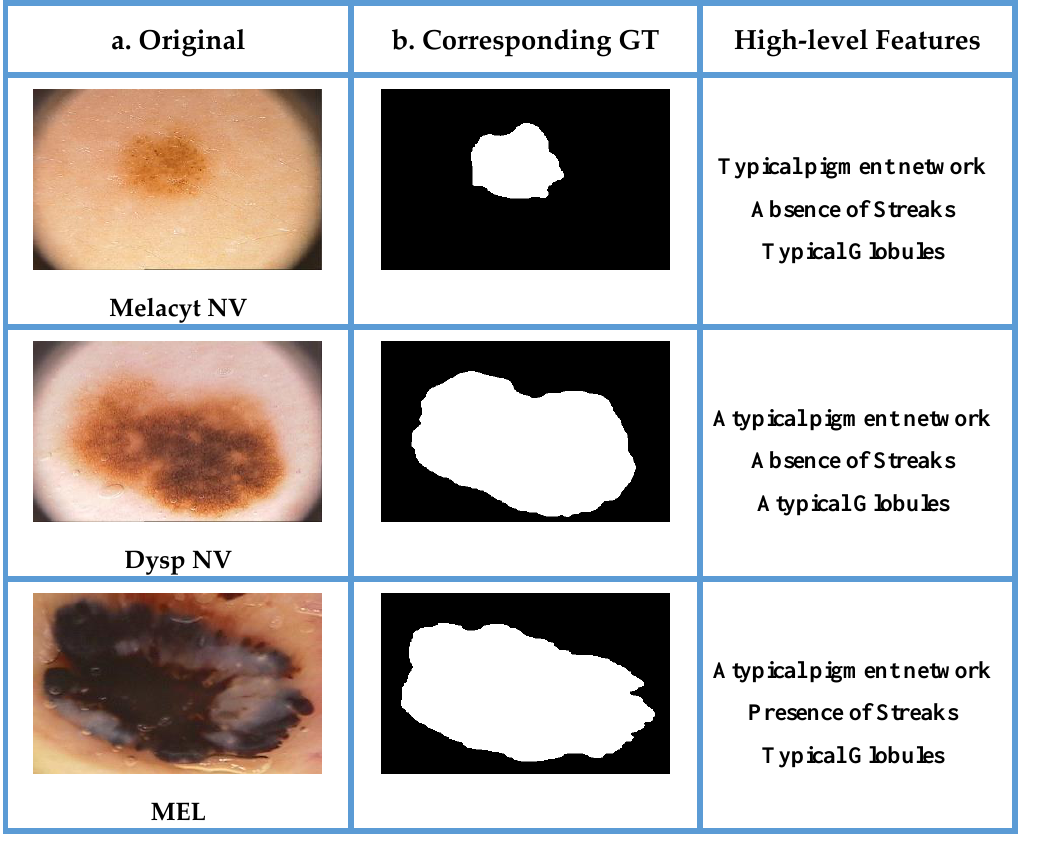
Figure 7. The o riginal Melanocytic nevi (Melcyt NV), Dysplastic nevi (Dysp NV), and malignant Figure 7. The original Melanocytic nevi (Melcyt NV), Dysplastic nevi (Dysp NV), and malignant melanoma (Mel) dermoscopic images and their corresponding ground truths (GTs). melanoma (Mel) dermoscopic images and their corresponding ground truths